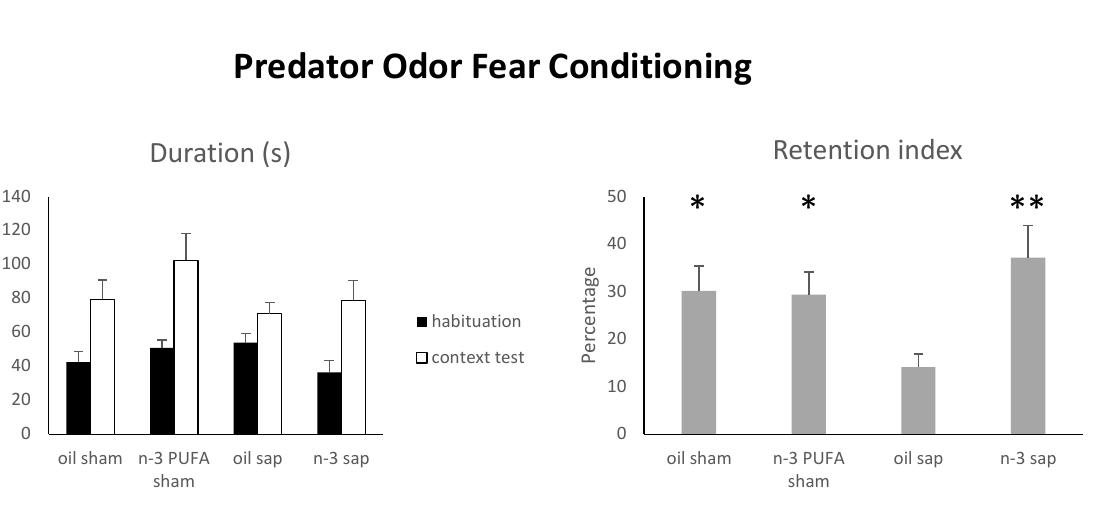
Figure 3. Predator Odor Fear Conditioning. Duration of freezing in the four experimental groups during habituation and context test sessions were used to calculate the retention index. Data are reported as mean and SEM (oil sham, n = 11; n-3 PUFA sham, n = 10; oil sap, n = 10; n-3 PUFA sap, n = 10). Asterisks indicate the level of statistical significance of the post-hoc comparisons between oil sap and the remaining groups: * p < 0.05, ** p <